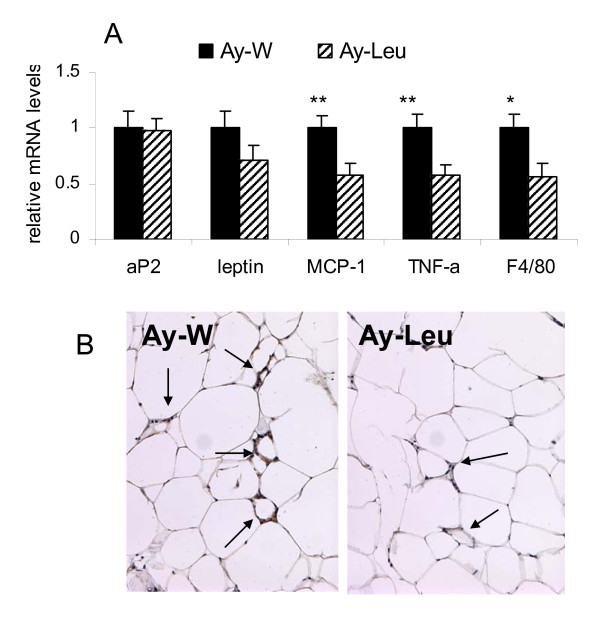
Leucine supplementation decreases adipose tissue inflammation in Ay mice. A: messenger RNA levels of aP2, leptin, monocyte chemoattractant protein-1 (MCP-1), tumor necrosis factor alpha (TNF-alpha), and F4/80, a macrophage-specific marker, in the epididymal adipose tissue of leucine-treated and control young Ay mice at the end of 4 month study period. The expression levels in leucine-treated mice are expressed relatively to the levels of the control mice. * and ** indicate p < 0.05 and 0.01, respectively, control vs. leucine-treated, n = 8. B. Immunohistochemical staining of F4/80 of epididymal adipose tissue of leucine-treated and control young Ay mice. The arrows indicate the nuclei positive for F4/80 staining.